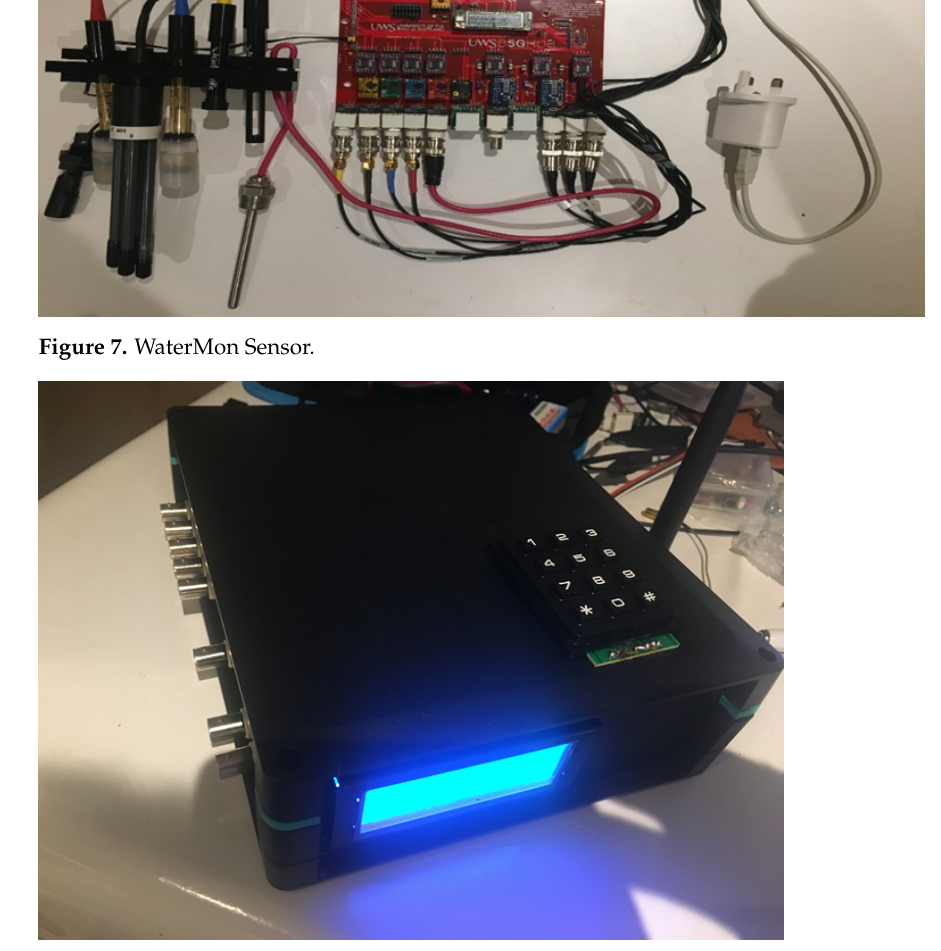
Figure 8. Sensor